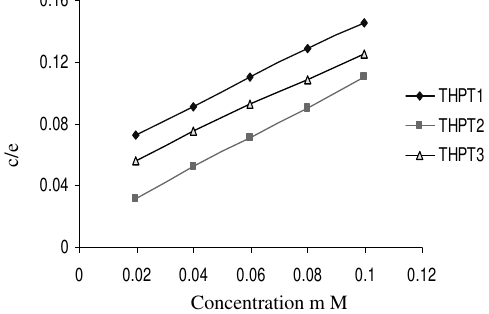
Figure 3. Langmuir plot of inhibitors in 1M H